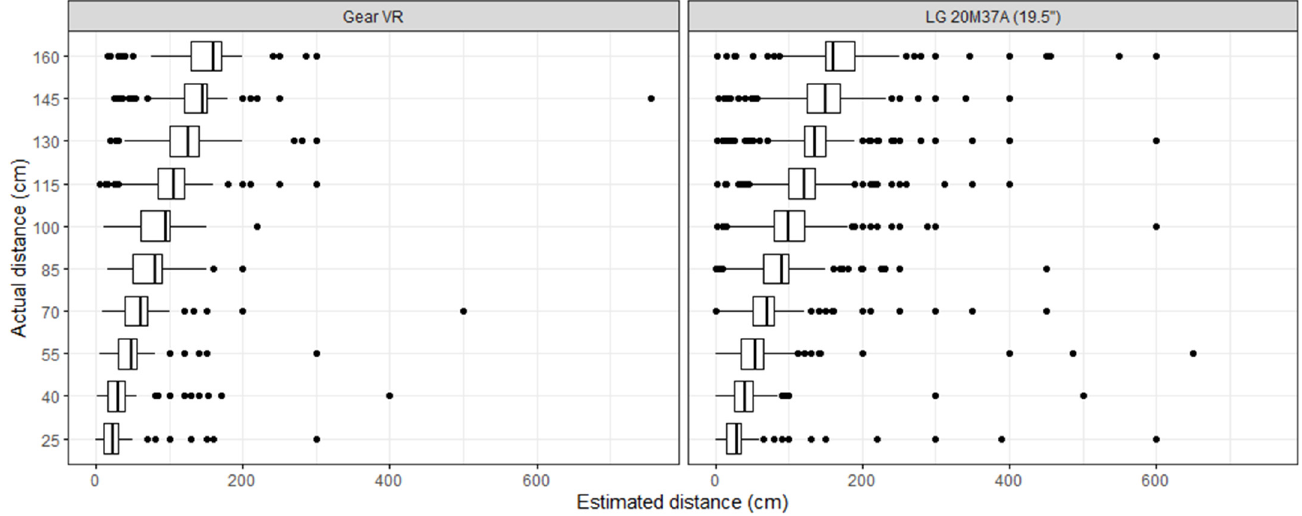
Figure 2. Distance estimates grouped by display devices.